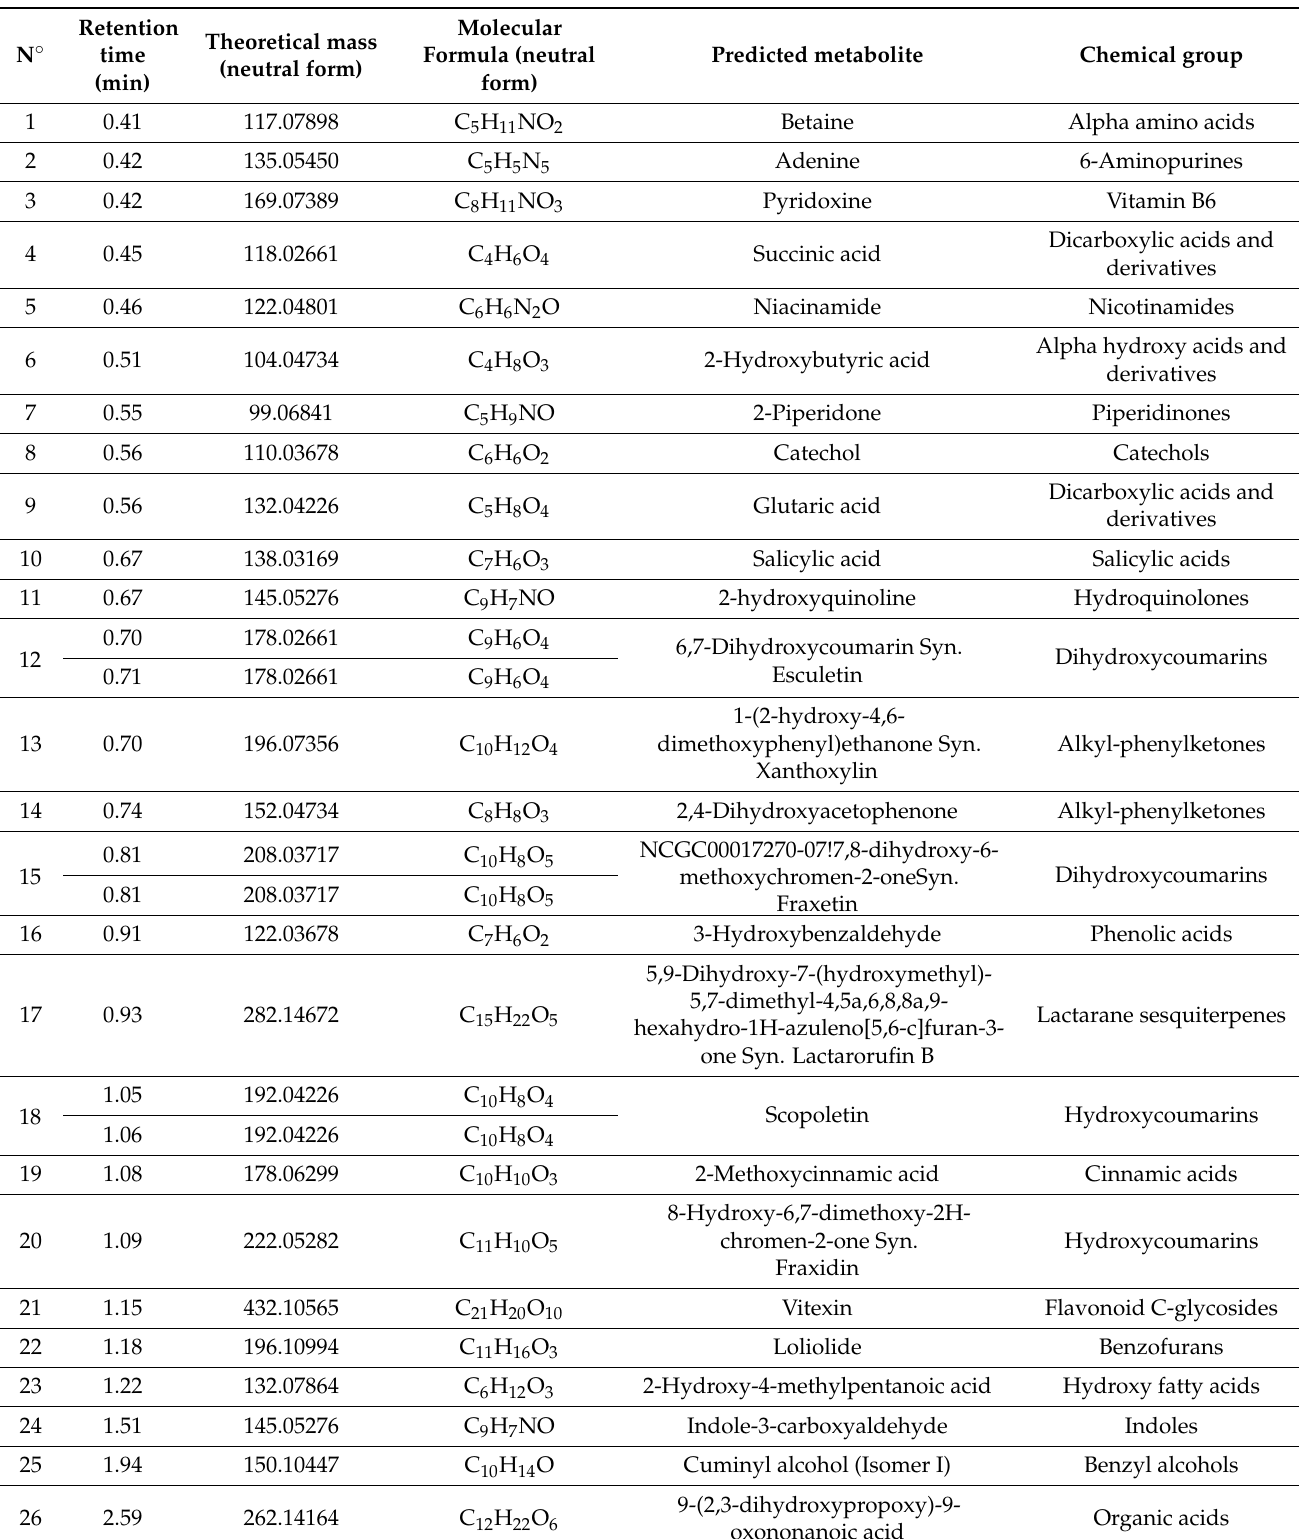
Table 3. Phytochemical constituents of stems of J. macrantha ethyl acetate fraction determined by